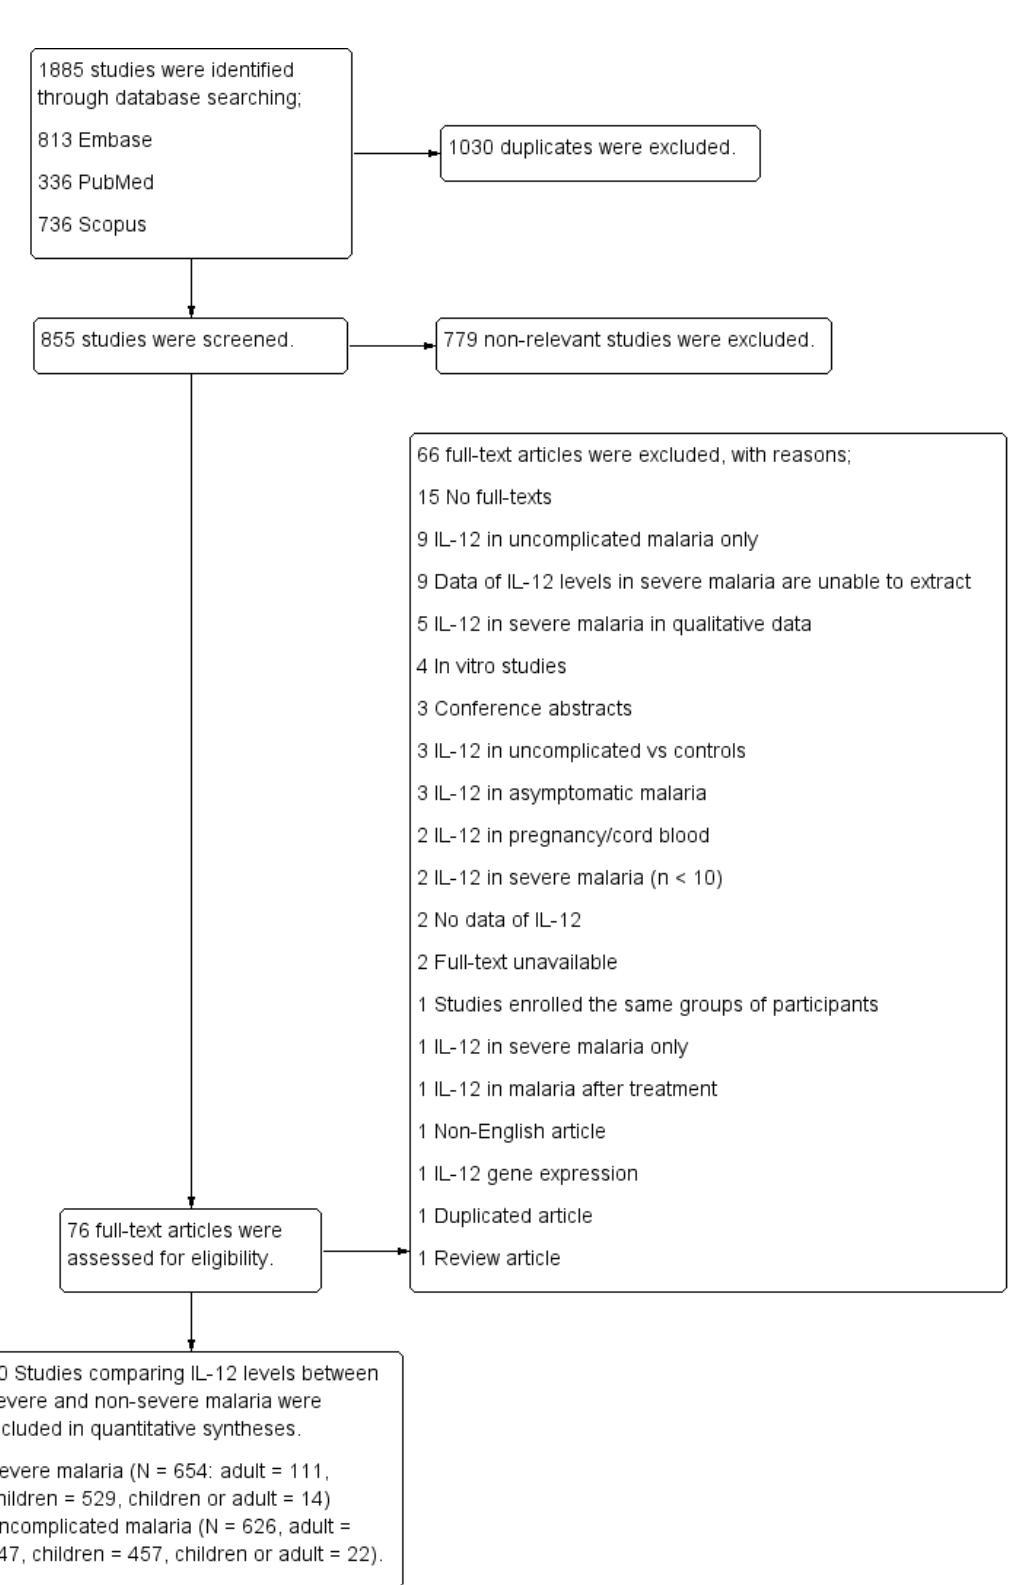
Figure 1. Study flow diagram.